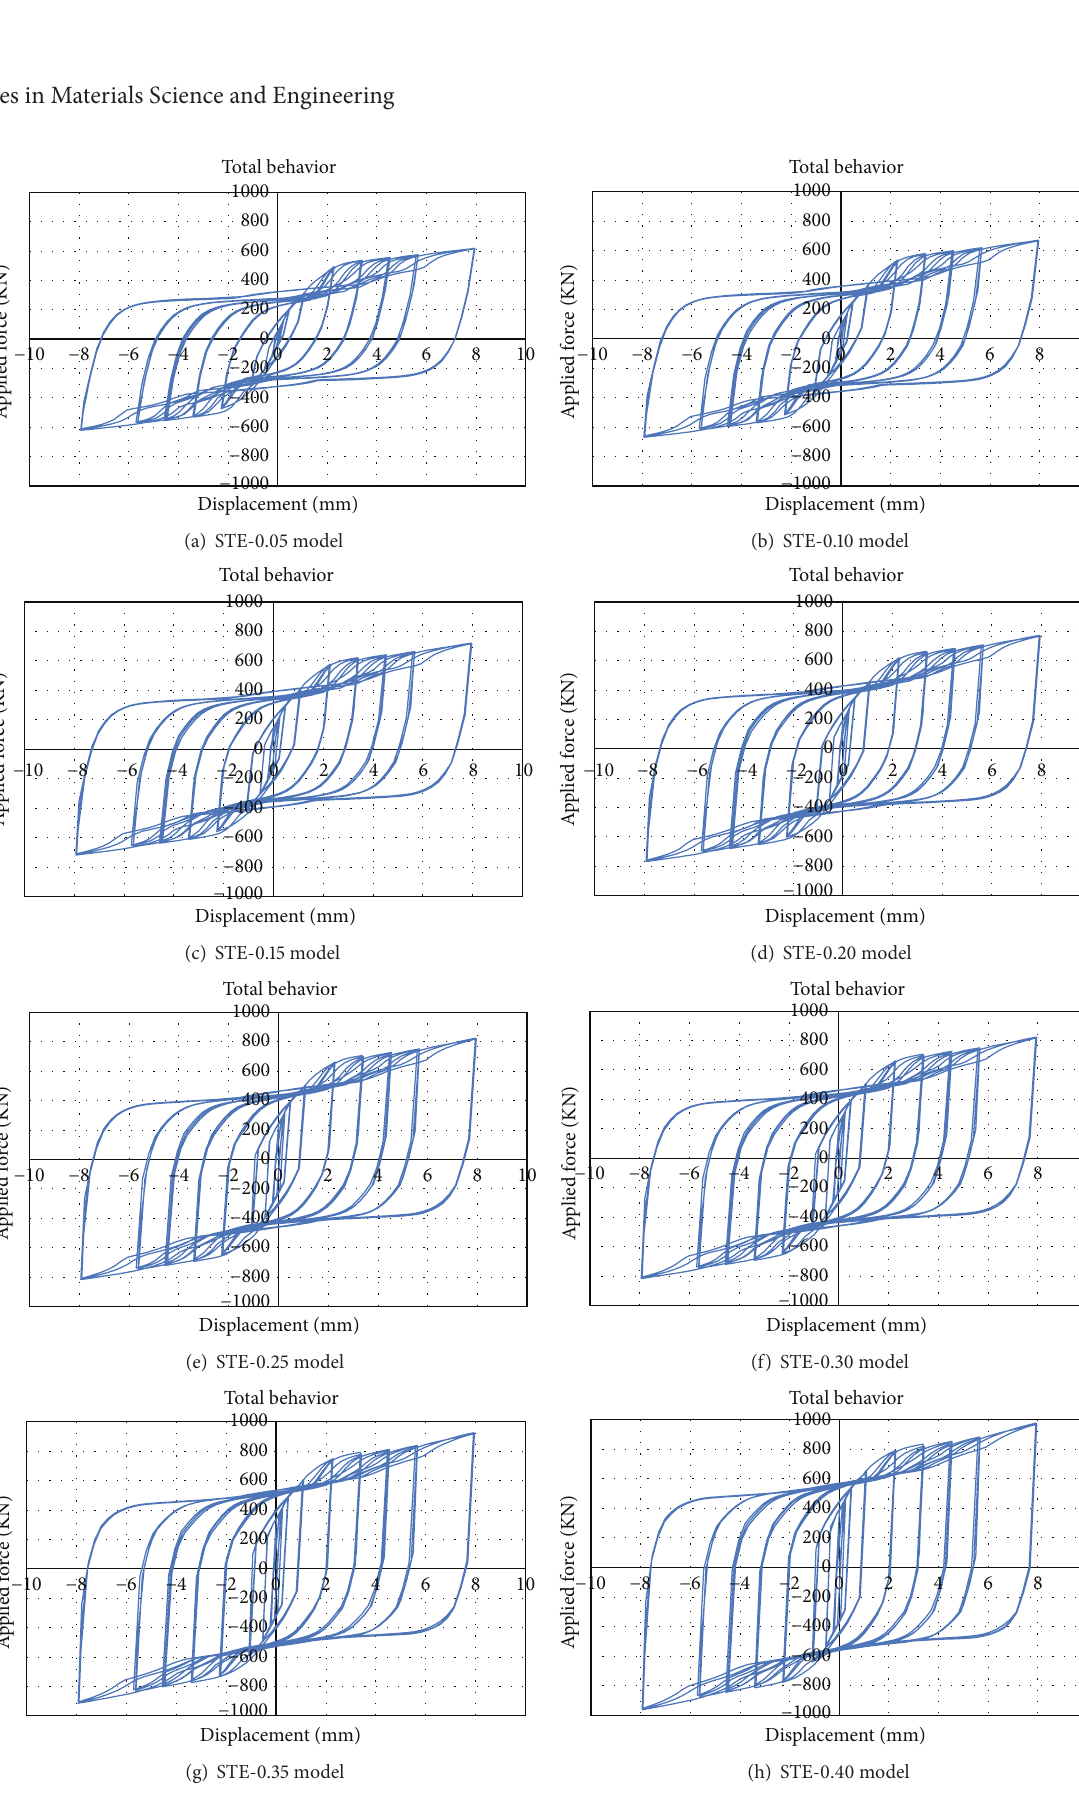
Figure 10: Total behavior of the traditional steel bearing systems with the friction